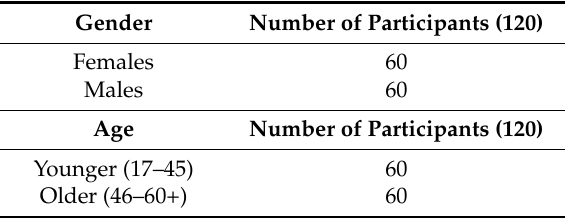
Table 1. Distribution of participants according to their gender and